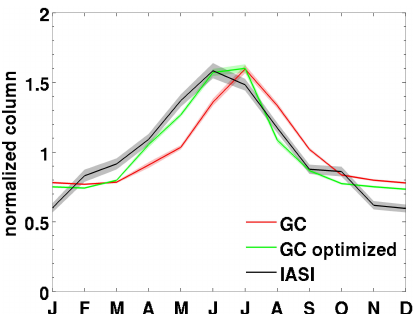
Fig. 7. Seasonal cycle in atmospheric methanol over midlatitudes as measured by IASI (black) and predicted by the GEOS-Chem base- case (red) and optimized (green) simulations. Data are for 2009 and are normalized by the annual mean in each case. Lines show the mean over all midlatitude regions of Fig. S2, while shaded areas indicate the standard error about the mean.